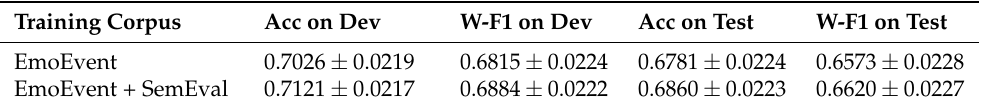
Table 3. Results on the development and test sets of the neural model trained with EmoEvent and with EmoEvent + SemEval. Training Corpus Acc on Dev W-F1 on Dev Acc on Test W-F1 on Test